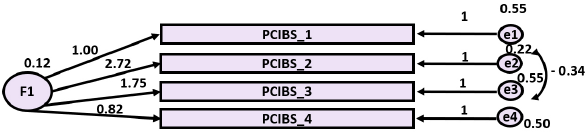
Fig. 2. CFA results of Model 2 of Portuguese version of PCIBS . Model fit indices: χ 2 /df: 1.123; RMSEA: 0.024; CI 90% LL; HL: 0.000; 0.183; p : 0.410; CFI: 0.998; TLI: 0.991; SRMR: